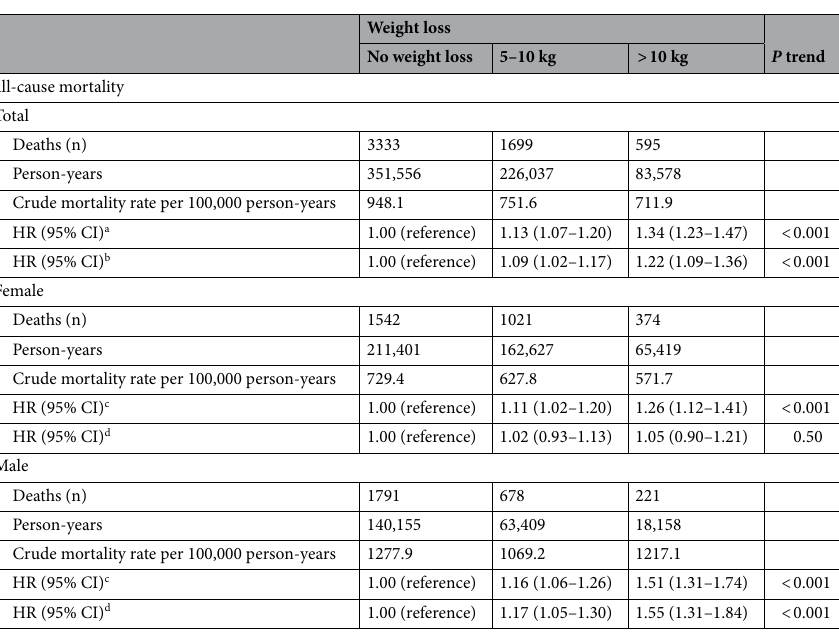
Table 2. Mortality rates and hazard ratios for the association between weight loss and overall mortality. HR hazard ratio, CI confidence interval. a Adjusted for age and sex at enrollment. b Adjusted for age, sex, body mass index, cigarette smoking, alcohol consumption, level of education, income, physical activity, sleep, and subjective health. c Adjusted for age at enrollment. d Adjusted for age, body mass index, cigarette smoking, alcohol consumption, level of education, income, physical activity, sleep, and subjective